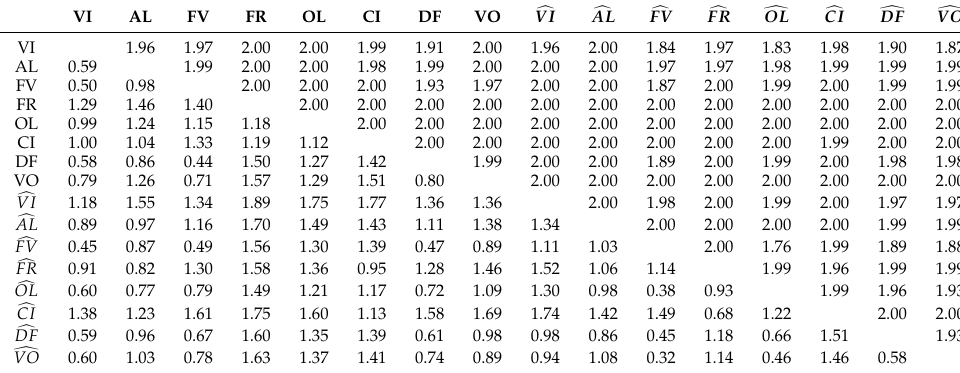
Table 3. JM distances between considered classes. The upper part shows the JM distances obtained after stacking 15 Sentinel-2 images, while in the lower part the average distance for the 67 images is shown. On the other hand, VI stands for abandoned Vineyard, while (cid:99) VI stands for the corresponding active class, following the same distinction for the rest of the